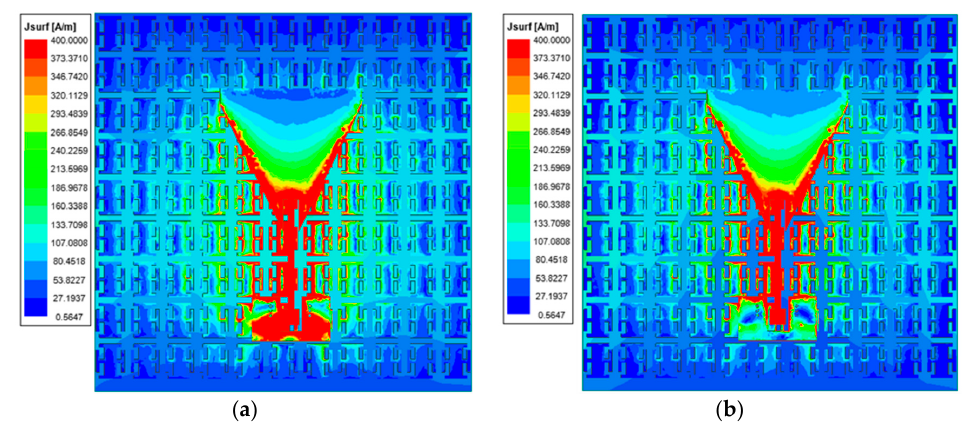
Figure 19. The surface current of the antenna-on-chip: ( a ) 38 GHz; ( b ) 60 GHz.